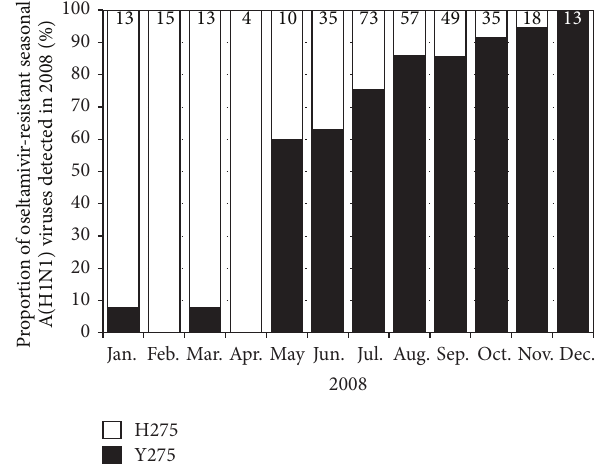
Figure 2: Proportion of oseltamivir-resistant seasonal A(H1N1) variants detected in the Asia-Pacific region during 2008. H275: oseltamivir-sensitivevirusesandY275:oseltamivir-resistantviruses. The number of virusestested from each month isindicated at the top of each